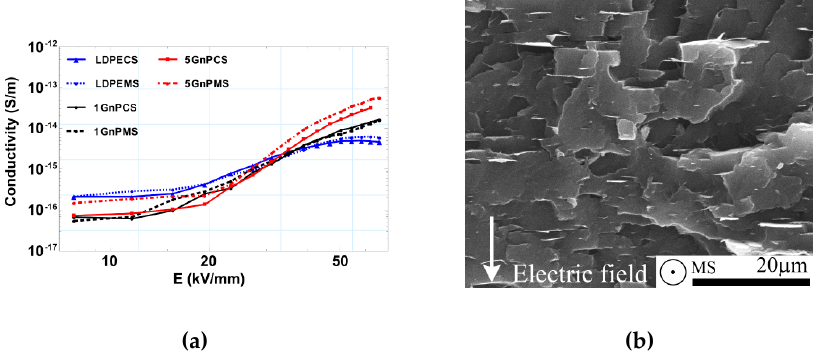
Figure 8. Field dependence of conductivity (30 min values) at 22 °C for pure LDPE and its GnP nanocomposites ( a ), direction of electric field ( b ).